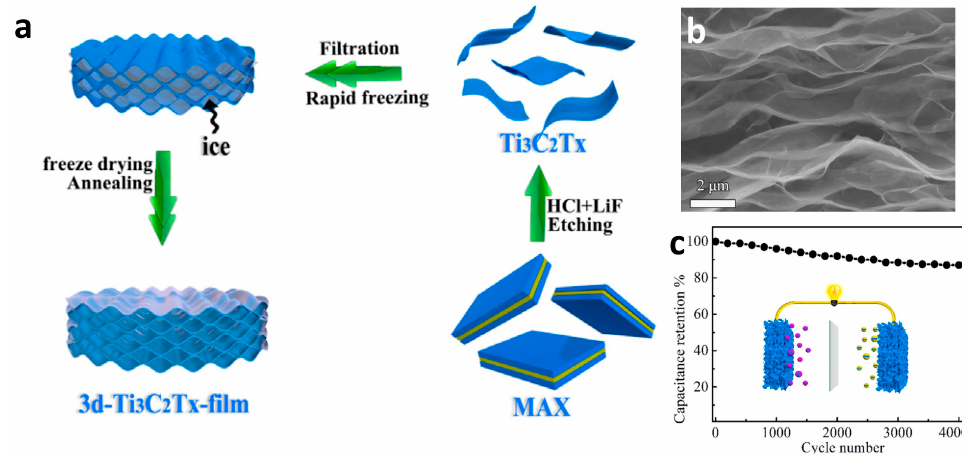
Figure 4. ( a ) Schematic of the preparation process of 3D Ti 3 C 2 T x film. ( b ) Cross-sectional SEM image of 3D Ti 3 C 2 T x film. ( c ) Prolonged cycling performance of the 3D Ti 3 C 2 T x film-based symmetric supercapacitor at 2 A g − 1 ; reproduced from [45], with the permission of Elsevier.